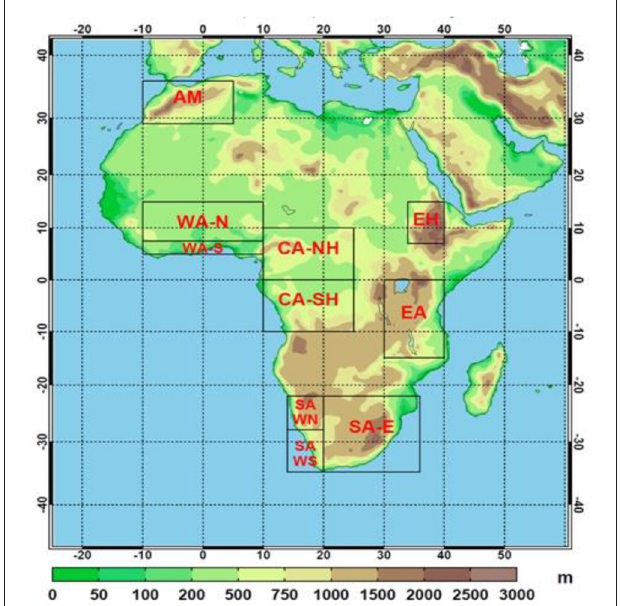
FIGURE 1 | CORDEX domain for model integrations over Africa showing topography in (m) (taken from